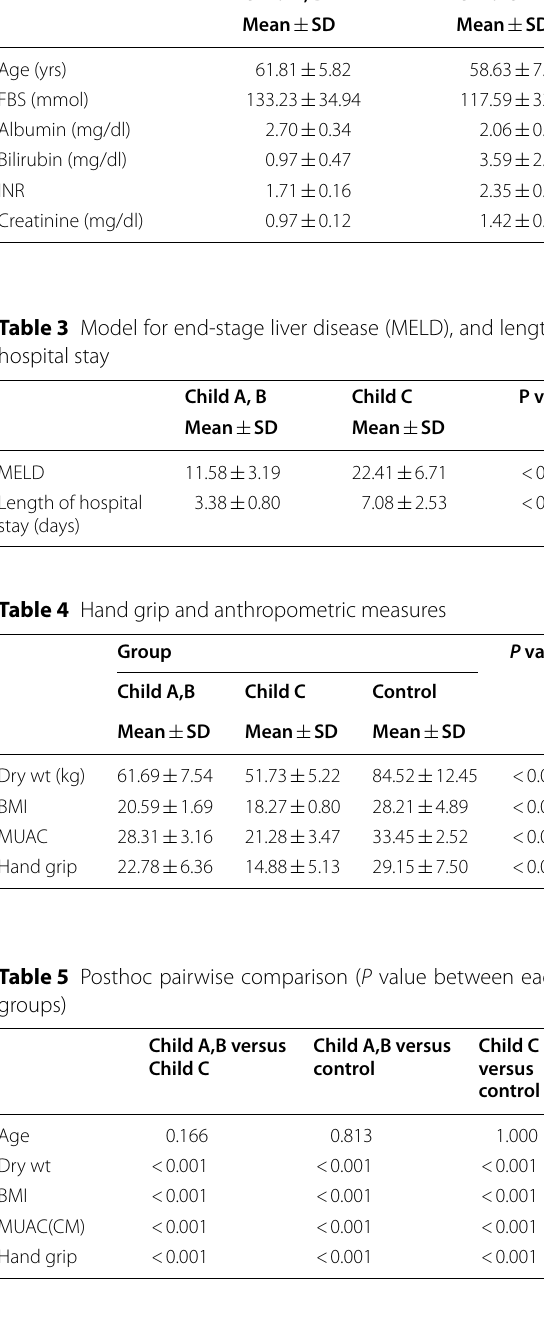
Table 4 Hand grip and Anthropometric measures. Table 5 Posthoc pairwise comparison (P value between each 2 groups).